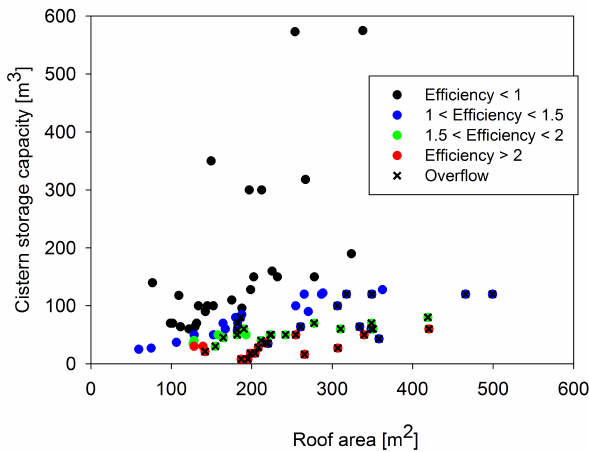
Fig. 8. Storage capacity and connected rooftop area of 79 active cisterns in Ramallah.